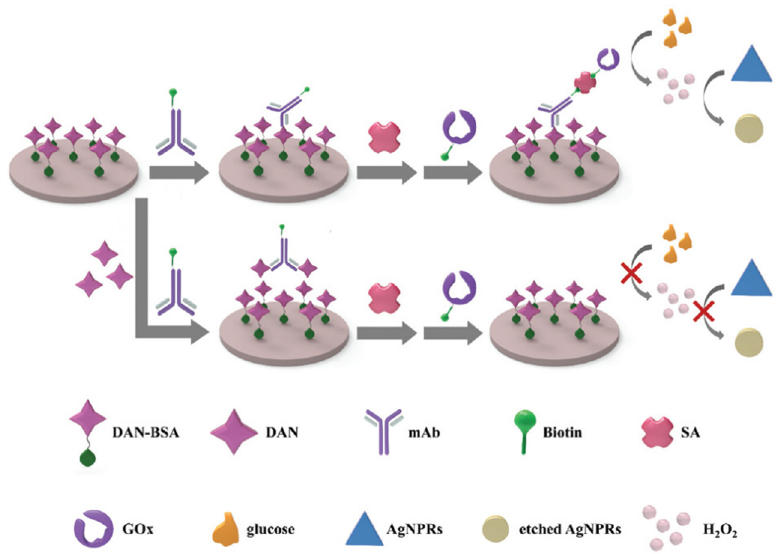
Figure 7. Scheme of the Ag nanoprisms-etching ELISA method for the detection of danofloxacin. Reprinted with permission from [98], copyright 2012, Royal Society of Chemistry.